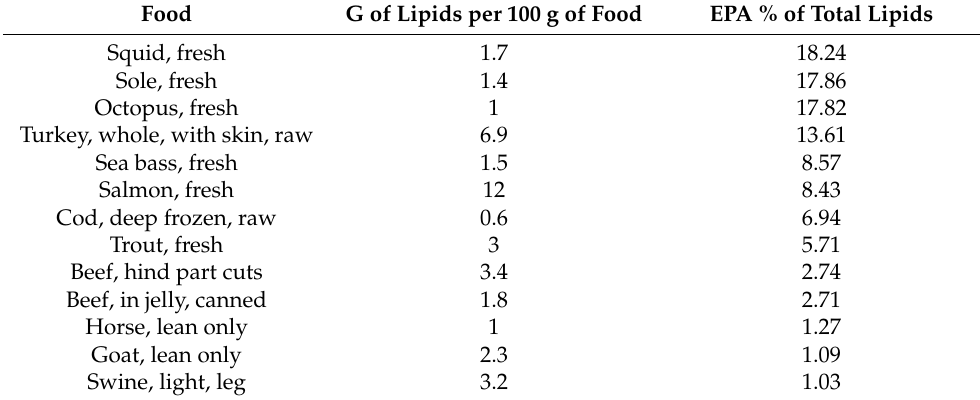
Table 3. Eicosapentaenoic acid (EPA) content of some fish/seafood and animal meat. Food G of Lipids per 100 g of Food